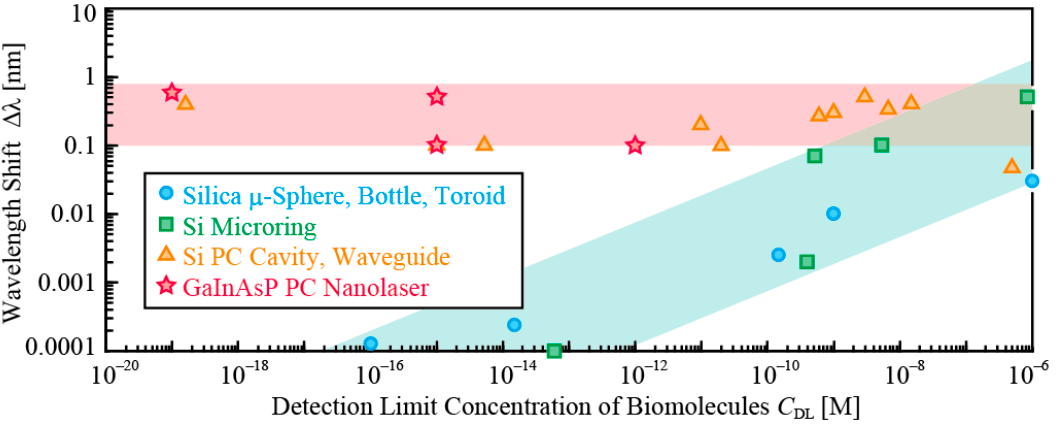
Figure 11. Relation between the wavelength shift and detection limit concentration of the target biomolecules for various label-free photonic biosensors that are operated based on optical resonance.